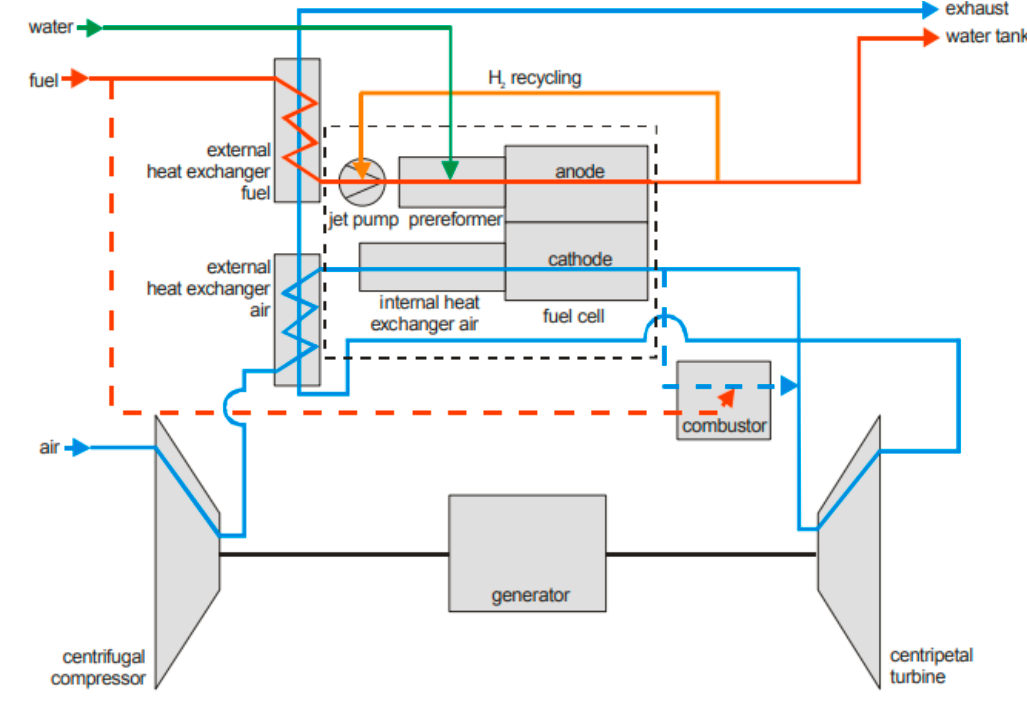
Figure 1. SOFC-GT APU system design as presented by Eelman et al. [11].